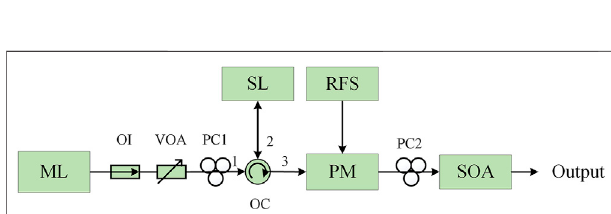
FIGURE 4 | Experimental setup of the proposed system. ML, master laser; SL, slave laser; RFS, RF source; PM, phase modulator; SOA, semiconductor optical ampli fi er; OI, optical isolator; VOA, variable optical attenuator; PC, polarization controller.